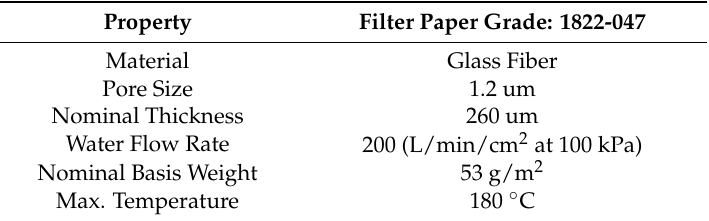
Table 3. Physical properties of Whatman™ filter paper.